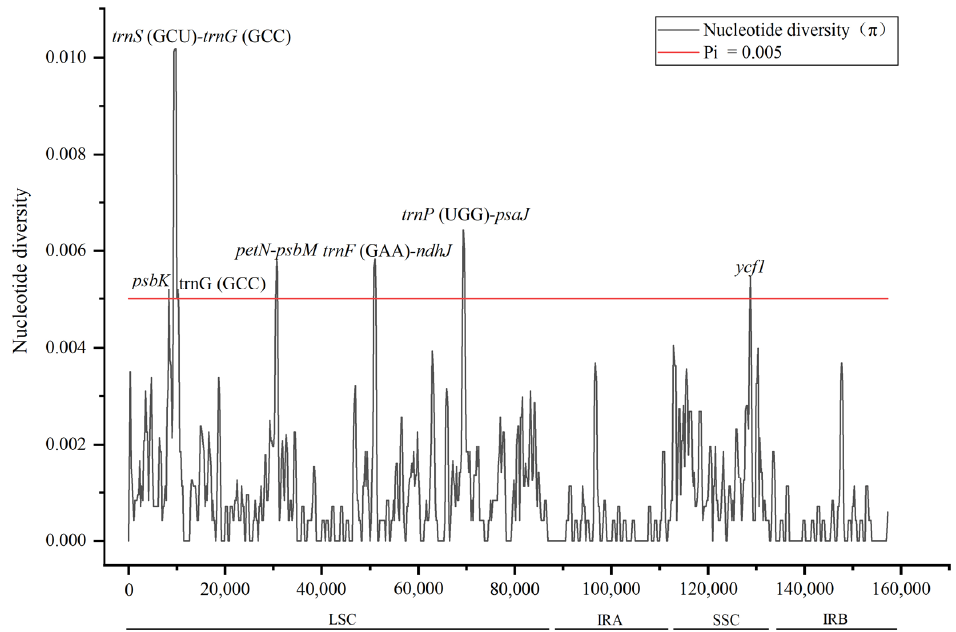
Figure 4. Nucleotide diversity of chloroplast genomes for C . ‘Xiari Qixin’ and seven Camellia species. The x -axis represents the base sequence of the alignment, and the y -axis represents the nucleotide diversity ( π ) value.